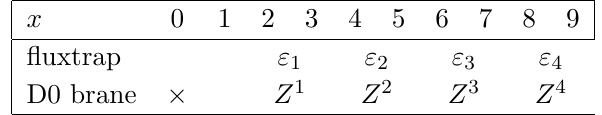
Table 1 . D0 brane and its scalar (cid:12)elds in the (cid:13)uxtrap